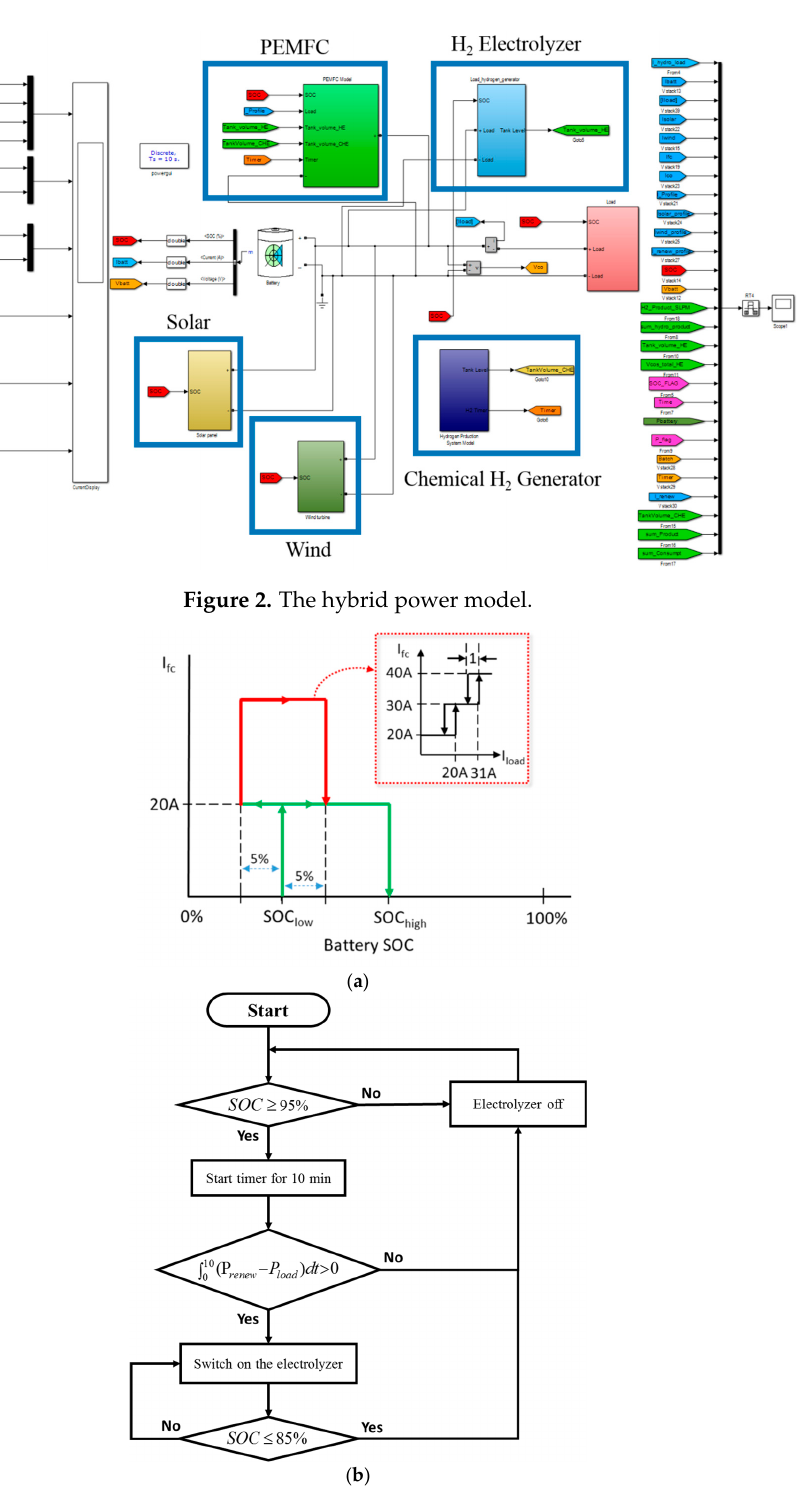
Figure 3. Power management. ( a ) The proton exchange membrane fuel cell (PEMFC) management [39]; ( b ) The electrolyzer management [33].